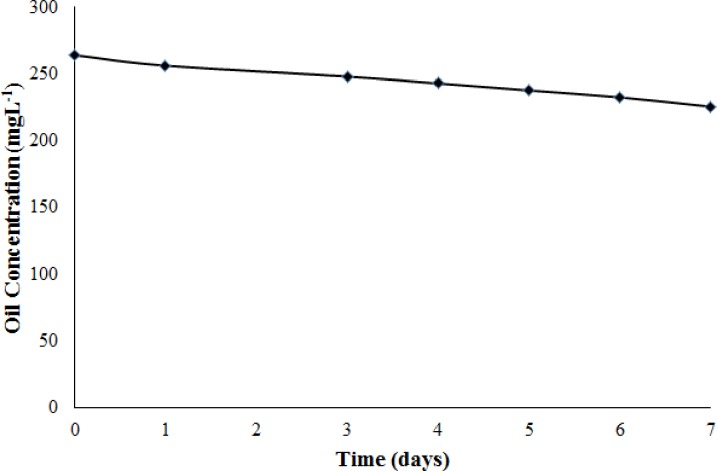
Stability of crude O/W emulsion over the time.